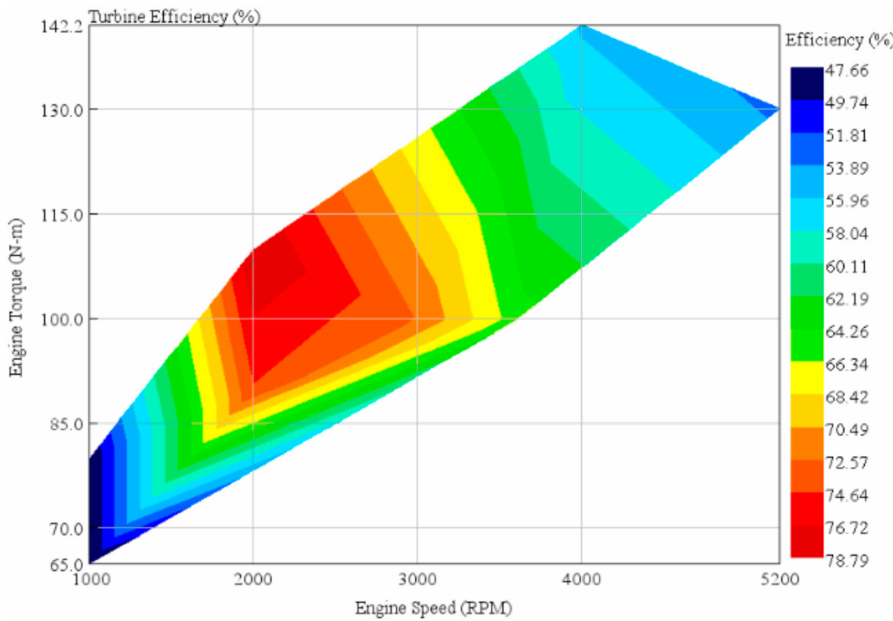
Figure 20. Turbine E ffi ciency Contour Plot.